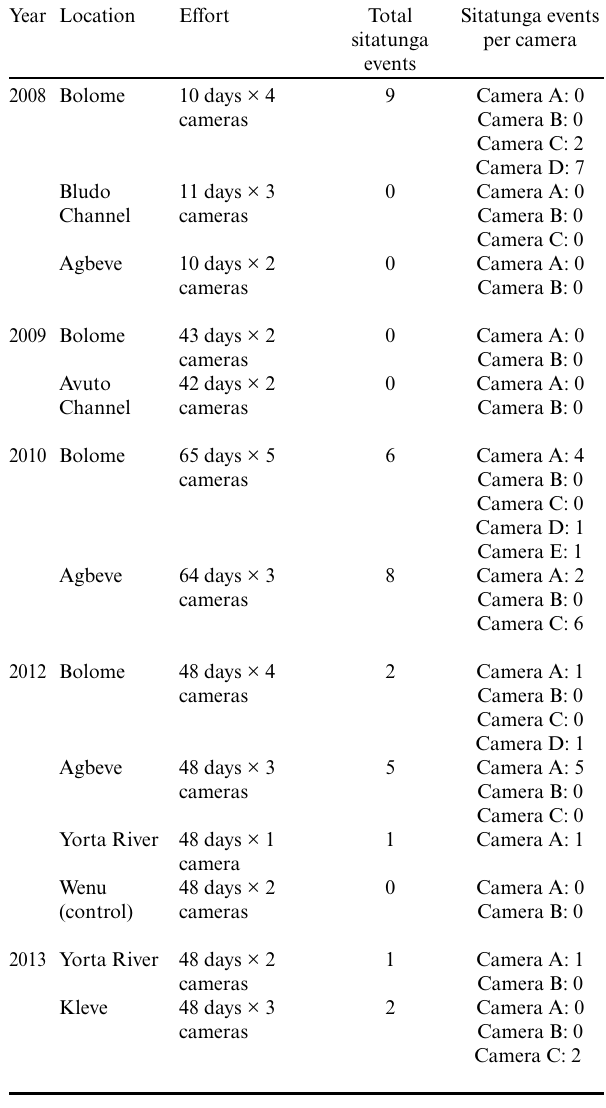
Table 2 . Overview of the temporal and spatial distribution of sitatunga events captured by camera traps 2008-2013.